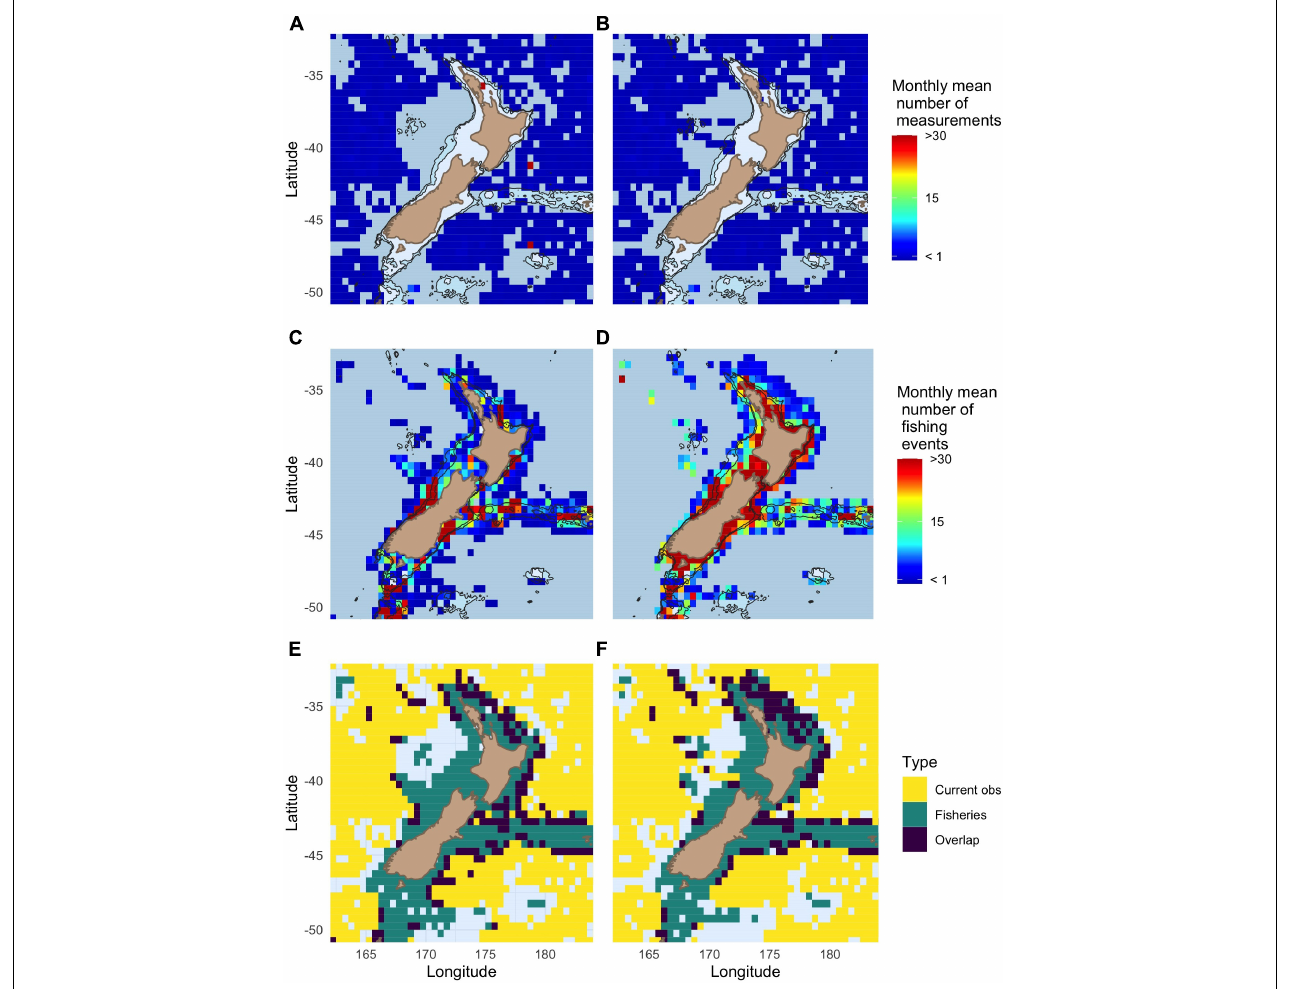
FIGURE 3 | New Zealand comparison of global (A,C,E) and local data sources (B,D,F) . (A) Mean monthly number of sub-surface observations from the global observation databases used in subsequent analyses. (B) Mean monthly number of sub-surface observations from local observation databases. (C) Mean monthly number of fishing events judged suitable for potential data collection from GFW data. (D) Mean monthly number of fishing events judged suitable for potential data collection from local databases. Data were provided by the New Zealand Ministry for Primary Industries (MPI) and prepared by David Middleton of Pisces Research Ltd. Bathymetry is indicated via contours corresponding to three depth classes going from lighter (shallower) to darker (deeper) blue matching the 200 m and shallower, 200 to 500 m, and 500 m and deeper depth classifications in other figures. (E,F) Corresponding to the data sources from the above maps, the grid cells with at least one fishing event or ocean observation, with overlap between the two plotted in